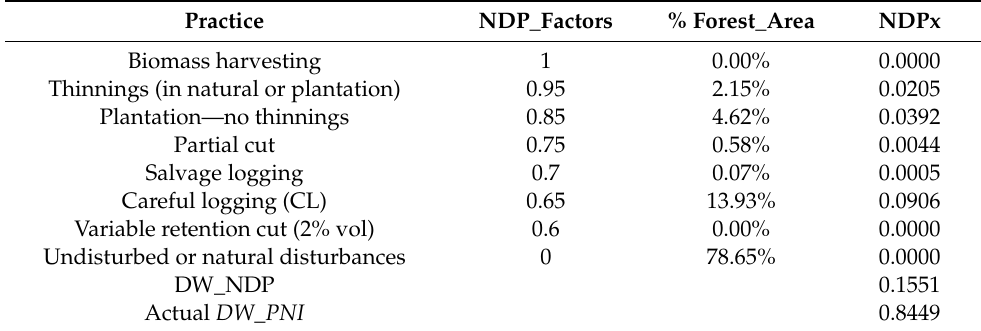
Table 5. Naturalness degradation potential (NDP) for dead wood (DW) by silvicultural treatments in Quebec’s boreal